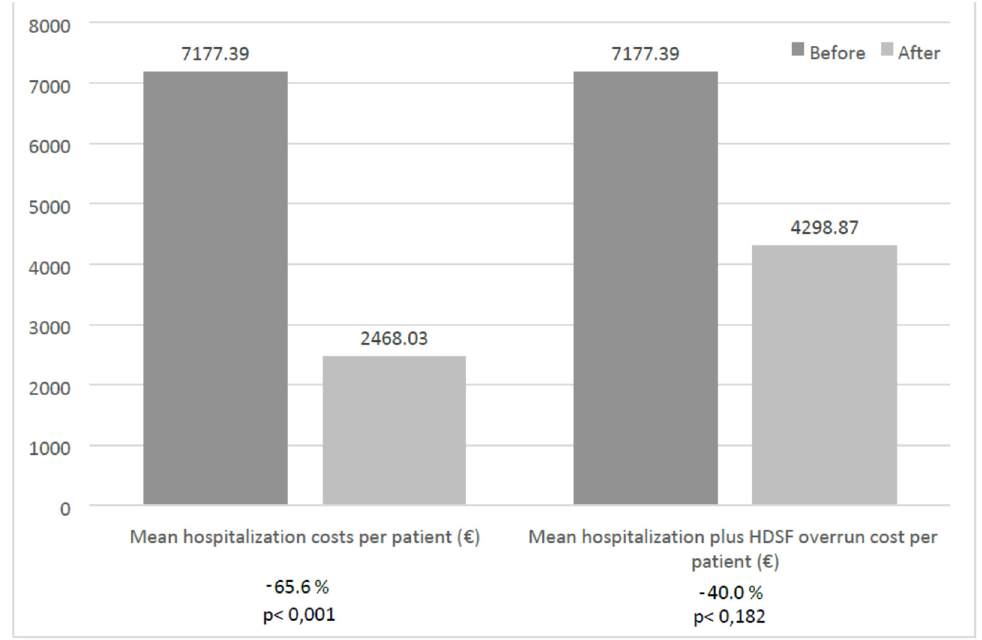
Figure 2. Hospitalization cost before and after treatment with HDSF. Mean hospitalization costs per patient are expressed as € . The percentage of cost reduction after HDSF is expressed as percentage and included under the bars.